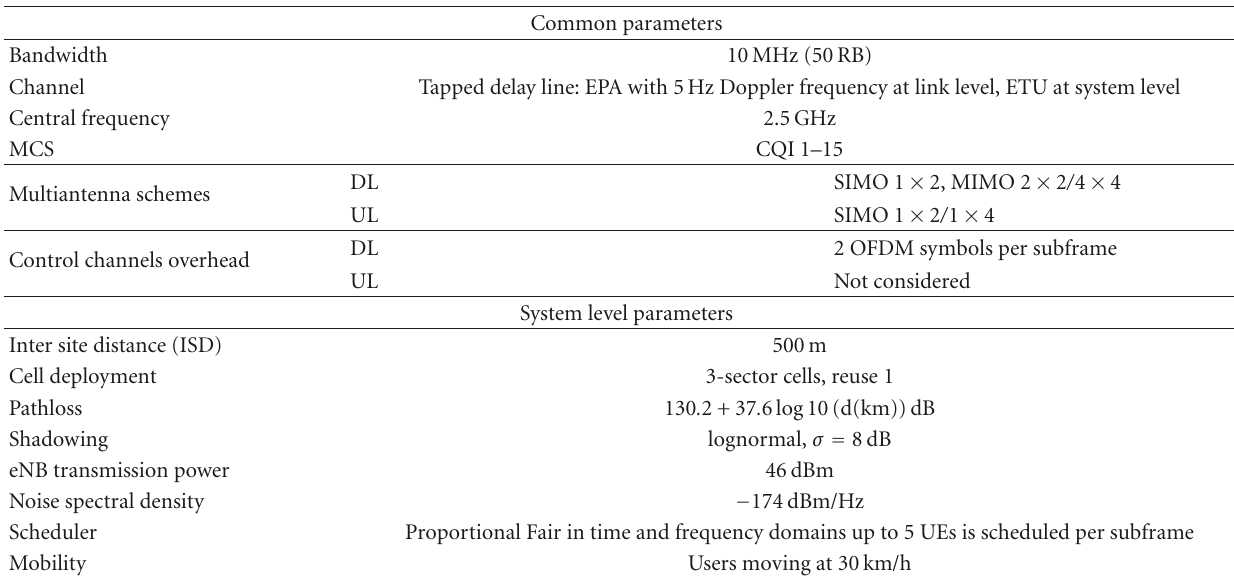
Figure 2: LTE peak spectral e ffi ciencies in downlink (a) and uplink (b). Table 1: Simulation